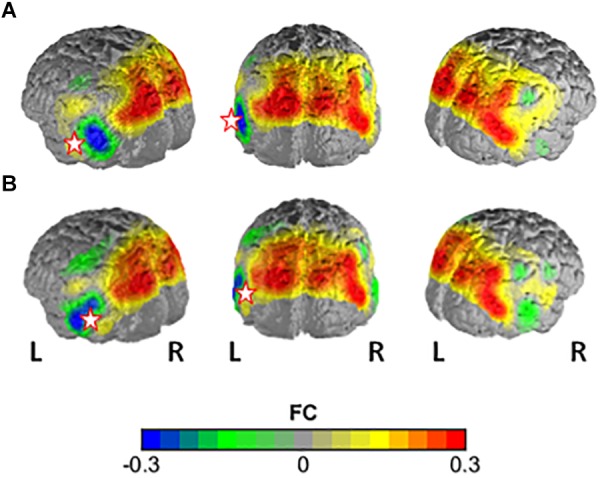
Difference in FC between the high-flourishing and regular-flourishing group with (A) channel 32 (lMTG) and (B) channel 43 (lFusG) as seed regions. Warm colors indicate higher FC with seed in high-flourishers vs. low-flourishers.